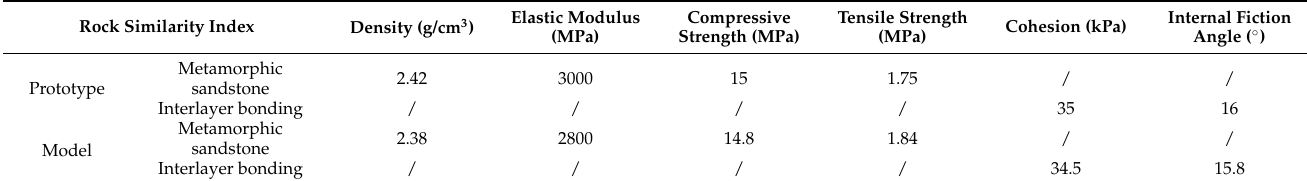
Table 1. Physical and mechanical parameters of prototypes and similar